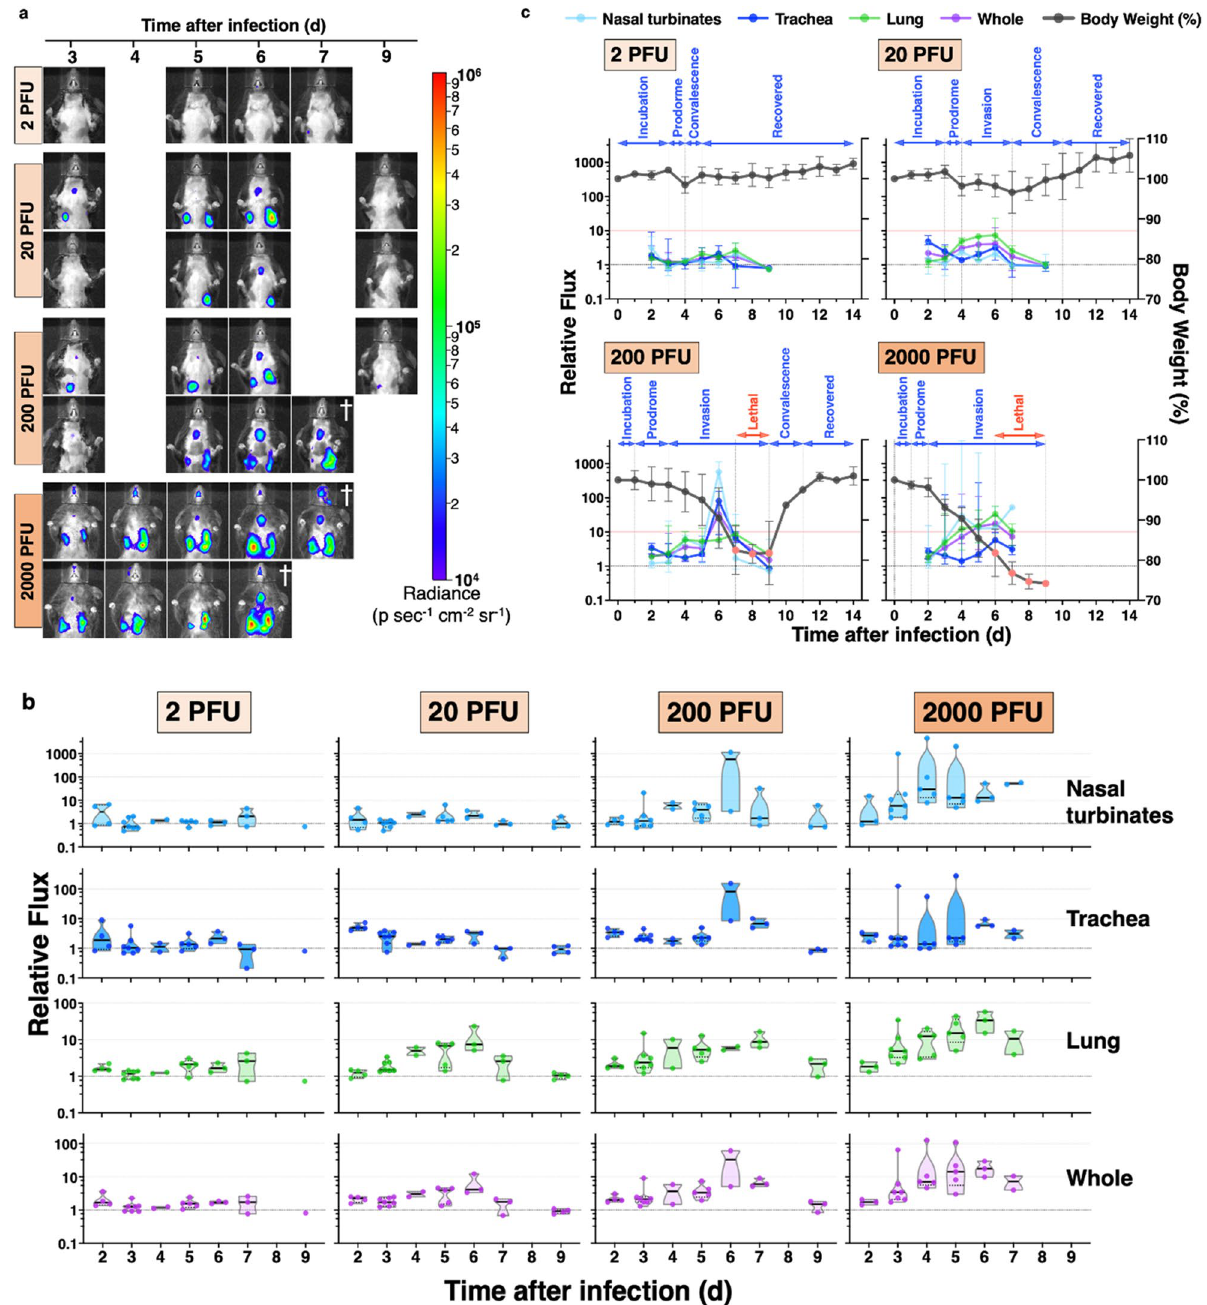
Figure 6. Real-time in vivo tracking of bioluminescent PB2-C-NanoLuc IAVs and spatiotemporal resolution of IAV replication kinetics in the mouse respiratory tract. ( a ) Bioluminescence from mice infected with PB2-C-NanoLuc IAV (2, 20, 200, or 2000 PFU) in the virulence study from 3 to 9 days after infection, expressed as radiance (p s −1 cm −2 sr −1 ). Each row of images was acquired longitudinally from 1 mouse. Differences in bioluminescence between mice were observed in the nasal turbinates (2000 PFU), trachea (200 PFU), and right or left lung (20 PFU). † Imaging performed before mouse was euthanized because of loss of > 25% of initial body weight. ( b ) Replication kinetics of bioluminescent PB2-C-NanoLuc IAV in mice at different infection doses. Relative bioluminescence flux at each region was the bioluminescence photon flux normalized to the mean flux from 3 mock-infected mice at the nasal turbinates (3.0 × 10 3 ± 8.7 × 10 2 photons s −1 ), trachea (2.4 × 10 4 ± 3.6 × 10 3 photons s −1 ), lung (5.8 × 10 4 ± 7.4 × 10 3 photons s −1 ), and whole body including head and torso (1.2 × 10 5 ± 1.2 × 10 4 photons s −1 ). Additional measurements were done at 2 and 5 days after infection to fill gaps resulting from the limited retro-orbital administration of substrate. There were 1 to 7 mice imaged at each time, except that there were no surviving mice at 9 days after infection with 2000 PFU. Data are shown as truncated violin plots with median (line) and first and third quartiles (dashed lines). ( c ) Relative flux for each IAV dose from the nasal turbinates, trachea, lung, and whole-body (median ± 95% confidence interval). Body weight (mean ± SD) after infection with bioluminescent IAV was replotted from Fig. 5b to facilitate comparison of the time course of relative flux and body weight. The natural history of influenza viral infection and progression in animals included incubation (no body weight drop after infection), prodrome (initial body weight drop), invasion (rapid or continuous loss of body weight), and convalescence periods (gaining of body weight) and recovered healthy condition (steady status of body weight). The lethal phase (red points) was defined by the loss of more than 25% of initial body